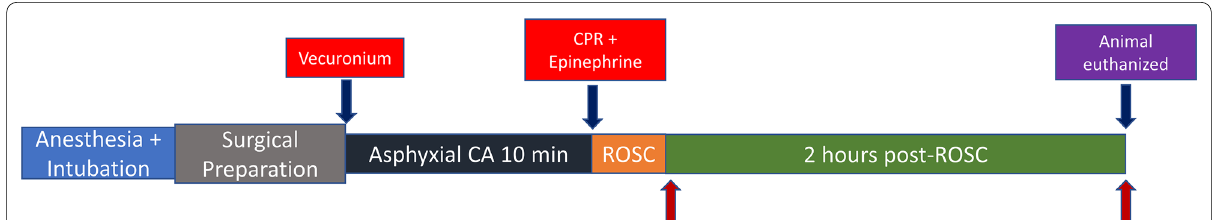
Fig. 1 Experimental schematic for asphyxial cardiac arrest (CA) 10 min followed by cardiopulmonary resuscitation (CPR) and successful achievement of return of spontaneous circulation (ROSC). Blood was drawn after ROSC and at 2 h post-ROSC as shown by the red